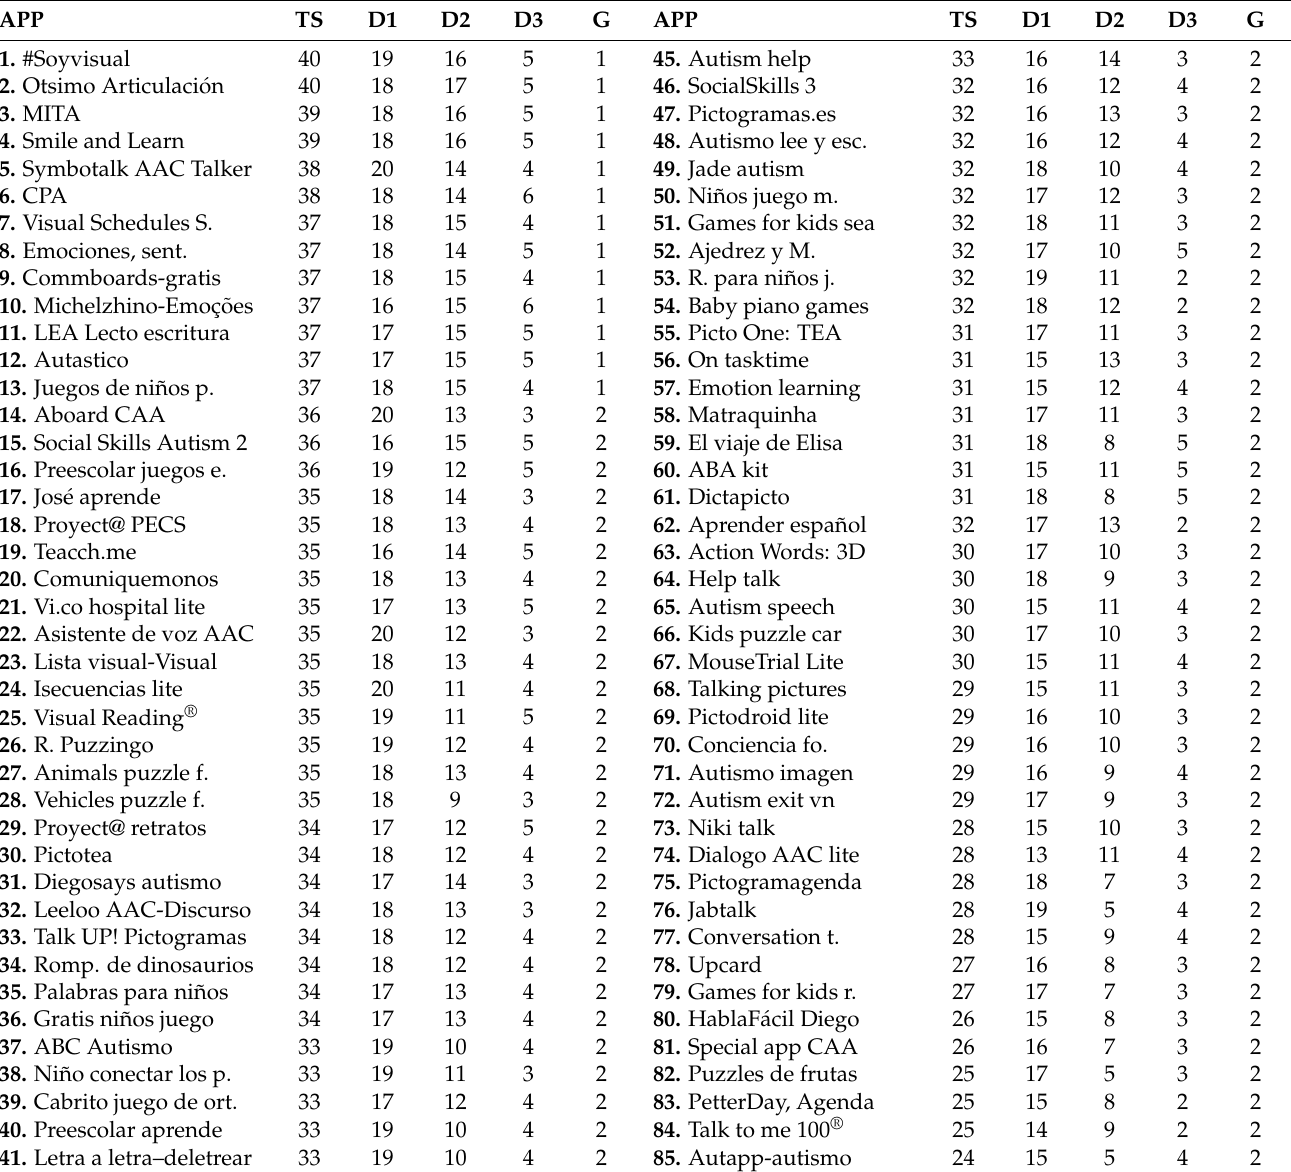
Table 2. Apps focused on basic instrumental skills, ordered according to the score obtained in the system of indicators.